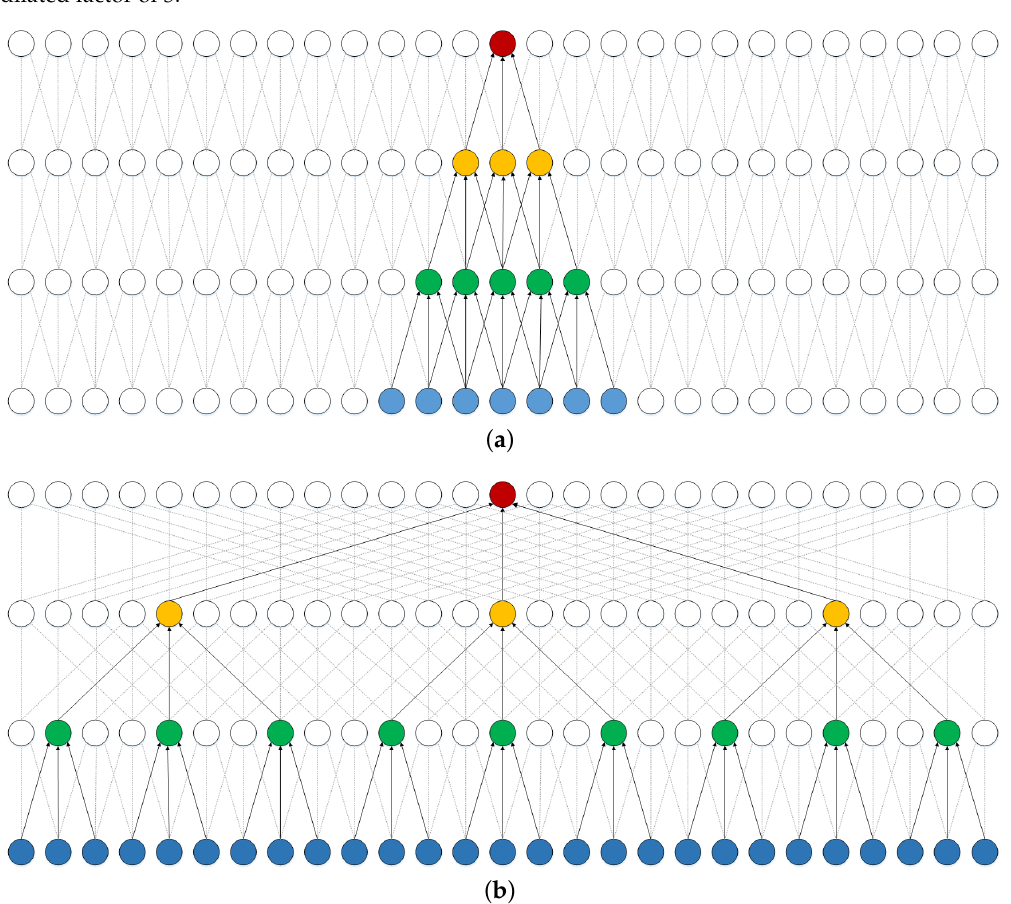
Figure 5. Receptive field of different convolution. ( a ) Ordinary convolution; ( b ) dilated